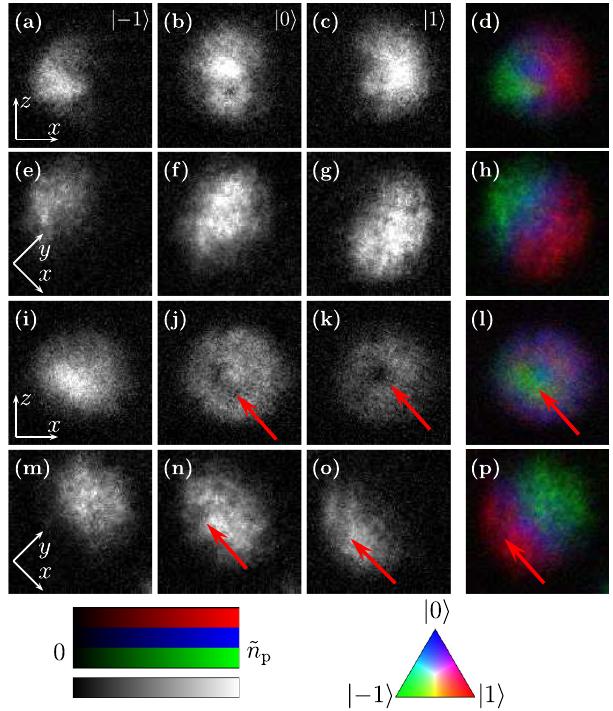
FIG. 5. Experimental column particle densities of (a – h) x - and (i – p) − y -quantized spin states. The first, second, and third columns correspond to spinor components ζ − 1 , ζ 0 , and ζ , þ 1 respectively, and the fourth column shows the corresponding 200 ms. The red composite image. Here, the hold time is t hold ¼ arrows indicate the locations of the nodal lines. The fields of view are as in Fig. 2, and the peak particle densities are (a – c,e – g,i – k, 5 . 0 × 10 8 cm − 2 , (d,l) ~ n 8 . 5 × 10 8 cm − 2 , and (h,p) m – o) ~ n p ¼ p ¼ ~ n 1 . 0 × 10 9 cm − 2 p ¼